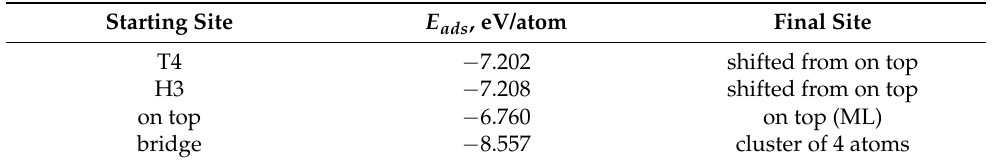
Table 2. Adsorption energies for C adsorbates on the GaN ( 000¯1 ) surface. Coverage 1 ML; 2 × 2 lateral cell.